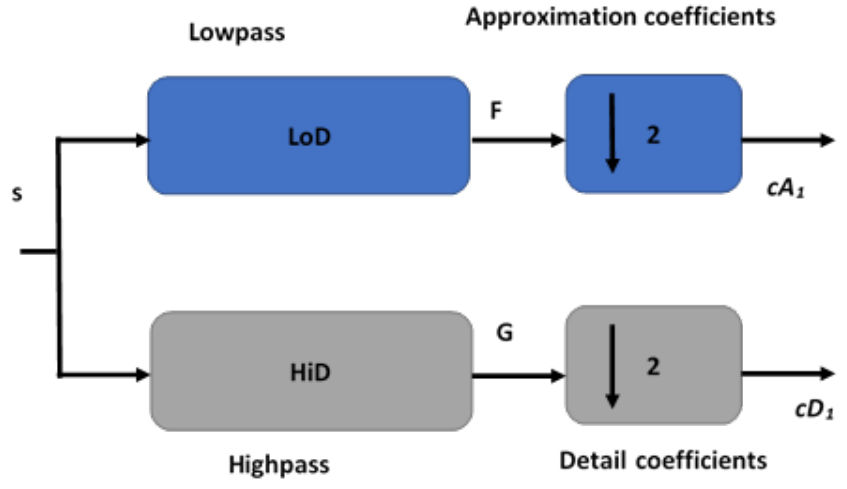
Figure 5. Filter bank of discrete wavelet transform.